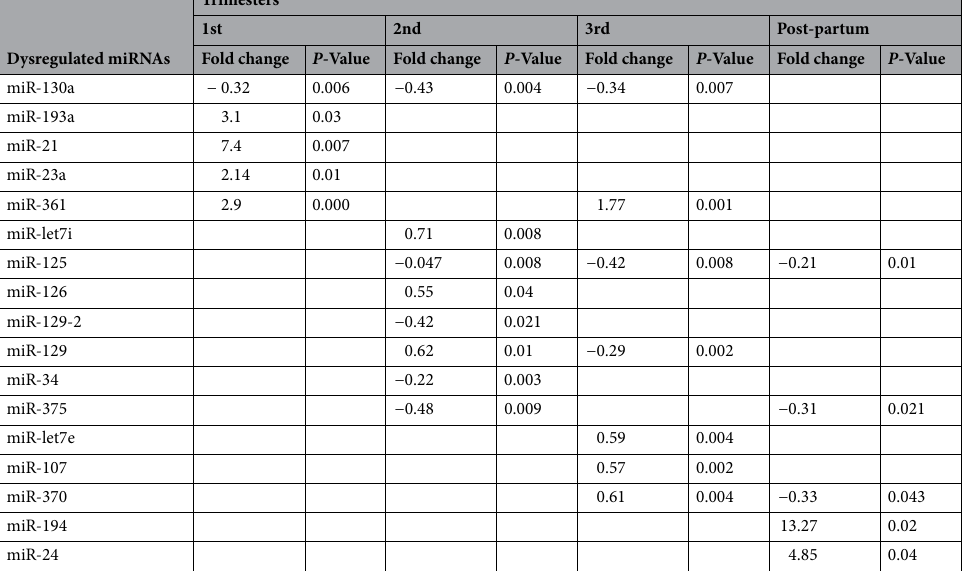
Table 2. Dysregulated microRNAs in each trimester and post-partum period of